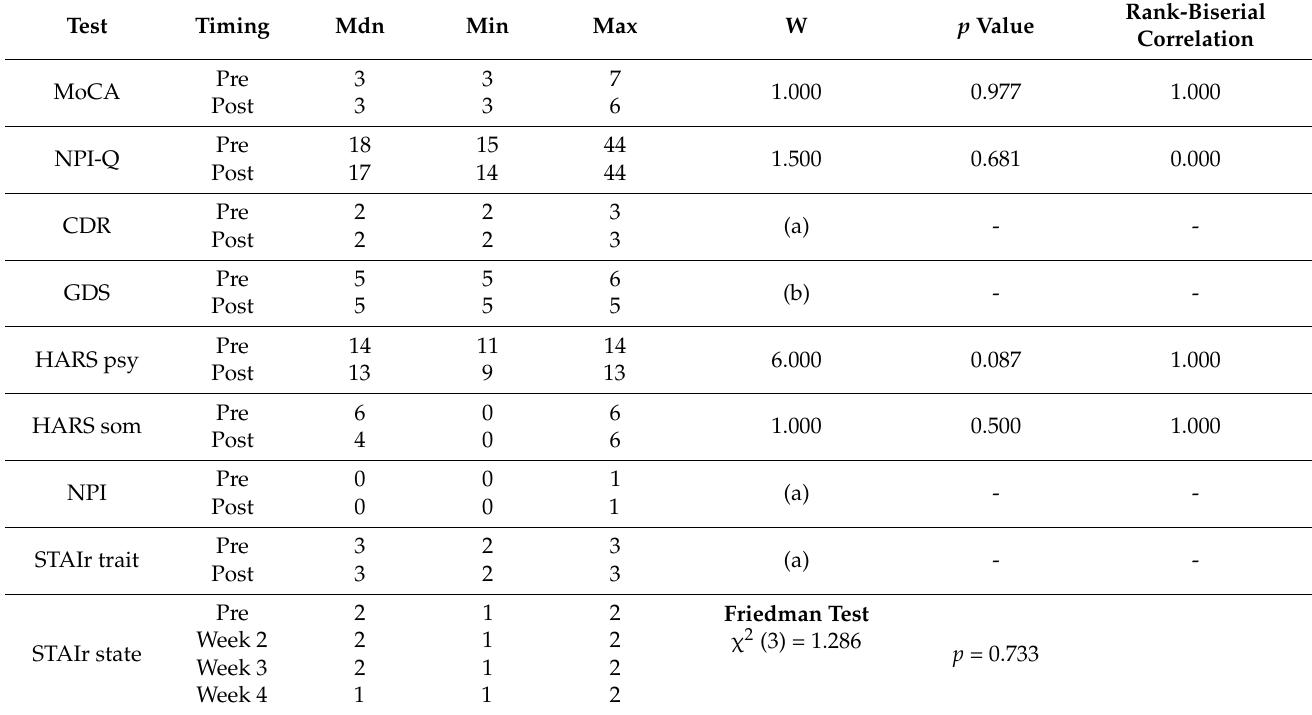
Table 4. Neuropsychological and anxiety scales results.